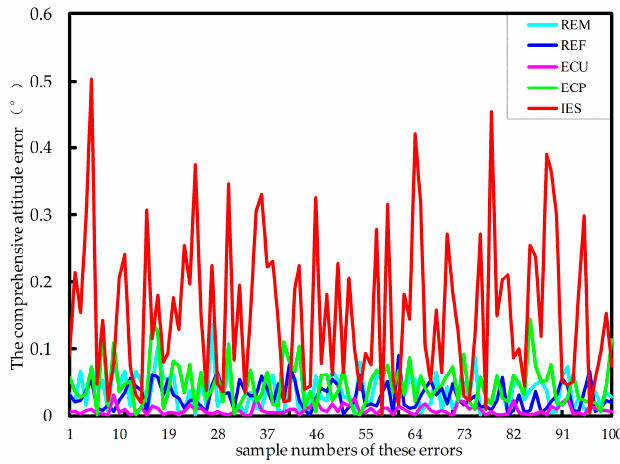
Figure 9. The influence of the five error sources on the comprehensive attitude error of the platform.